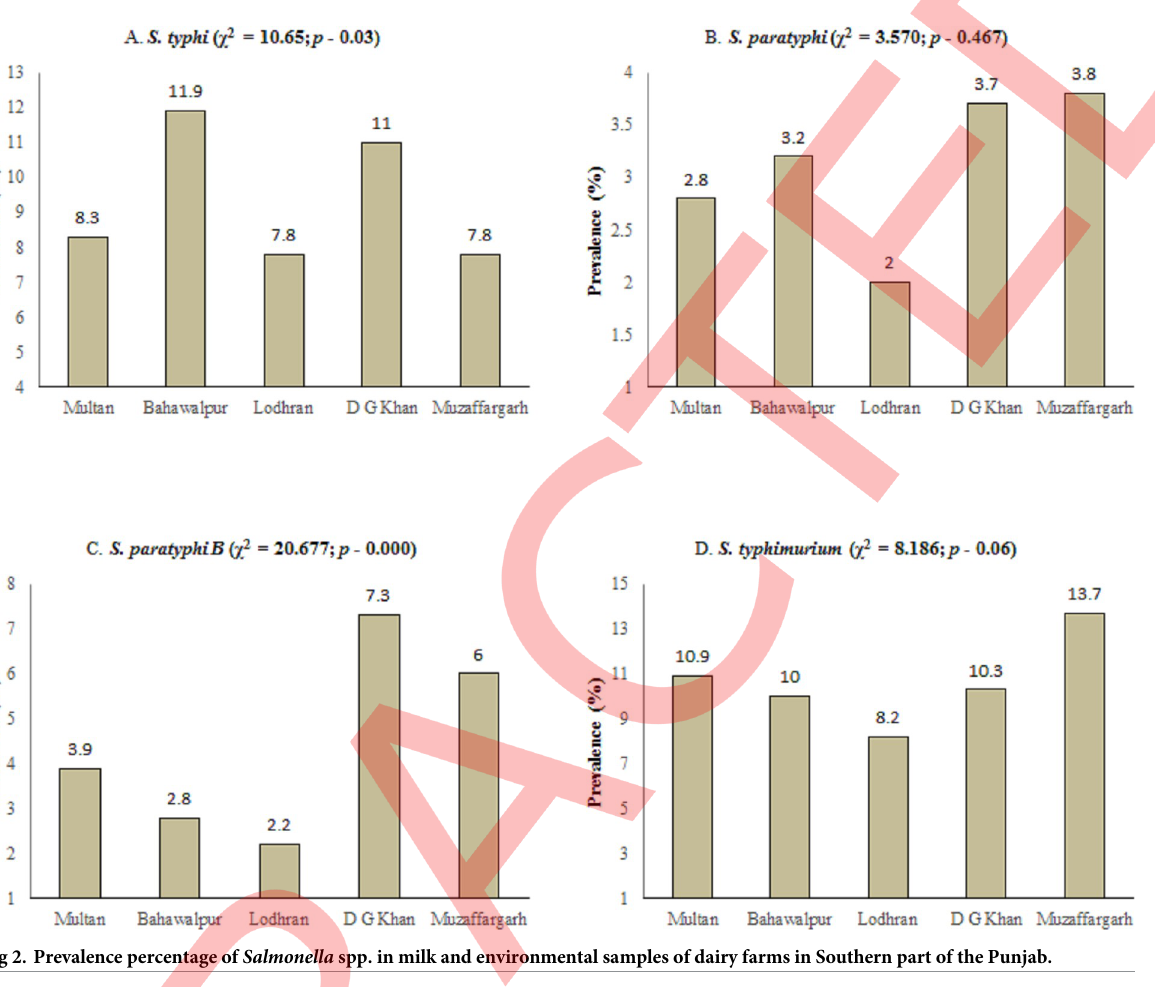
Fig 2. Prevalence percentage of Salmonella spp. in milk and environmental samples of dairy farms in Southern part of the Punjab.